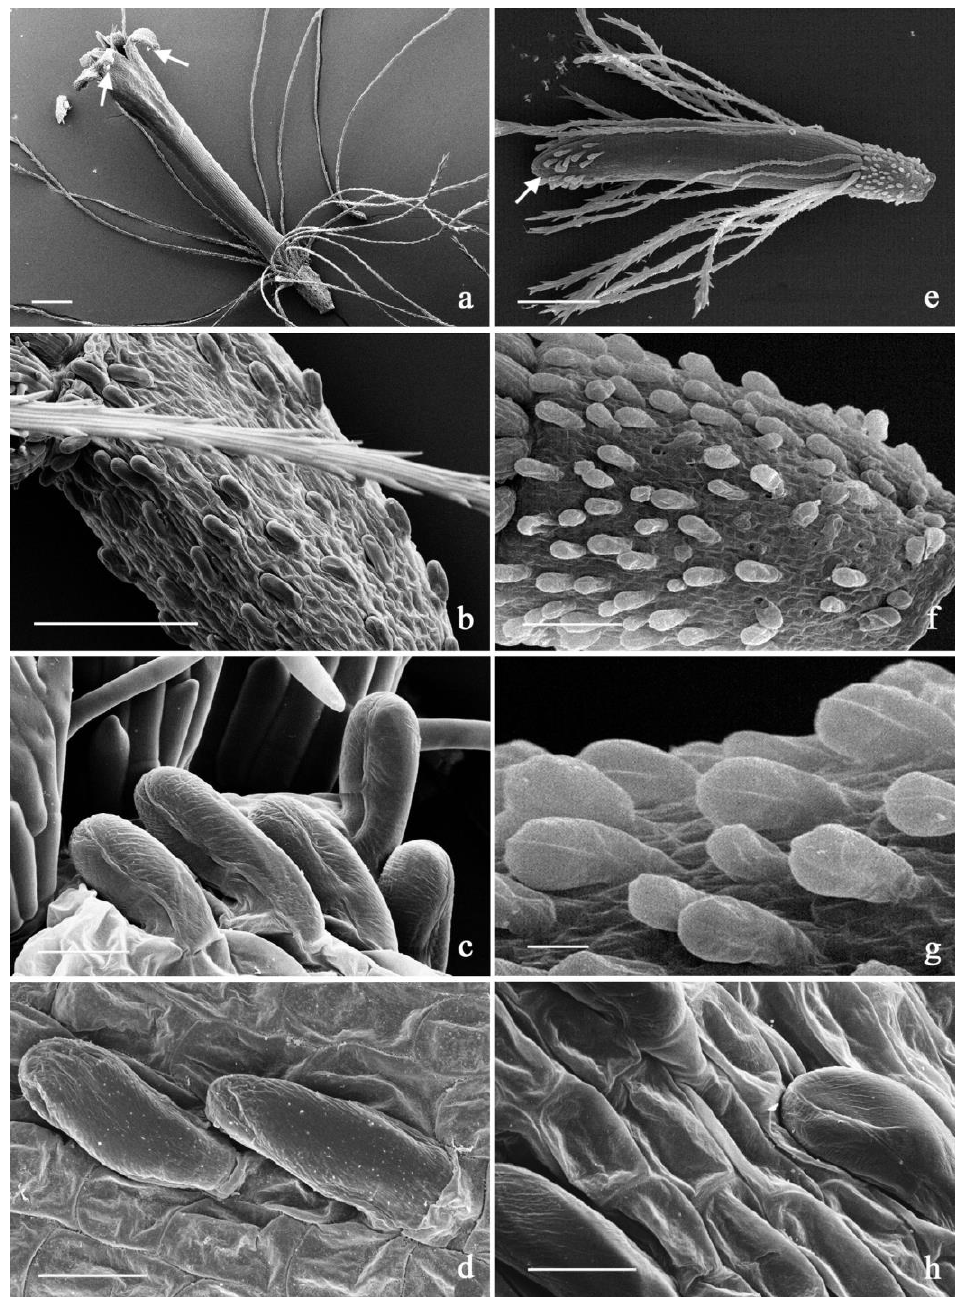
Figure 3. ( a – d ). SEM micrographs showing the distribution pattern of trichome morphotypes in the investigated Helichrysum A population (Capo d’Enfola). ( a ). General view of a mature floret. ( b ). Particular the ovary with duplex glandular trichomes. ( c , d ). Details of the duplex glandular trichome morphotype. ( e – h ). SEM micrographs showing the distribution pattern of trichome morphotypes in the investigated Helichrysum B population (Monte Capanne) ( e ). General view of a mature floret. ( f ). Particular the ovary with duplex glandular trichomes. ( g , h ). Details of the duplex glandular trichome morphotype. Scale bars = 200 µ m ( a , e ); 80 µ m ( f ); 25 µ m ( c , d , g ); 10 µ m ( b , h ). The distribution pattern of trichome morphotypes in leaves over the two Helichrysum populations analyzed through SEM indicated that the leaves of all samples were covered by long filamentous non-glandular hairs on the abaxial and adaxial surfaces (Figure 2a–f). These hairs formed a dense indumentum that completely obscures the epidermises, making complex the sample preparation for light microscopy investigations. These